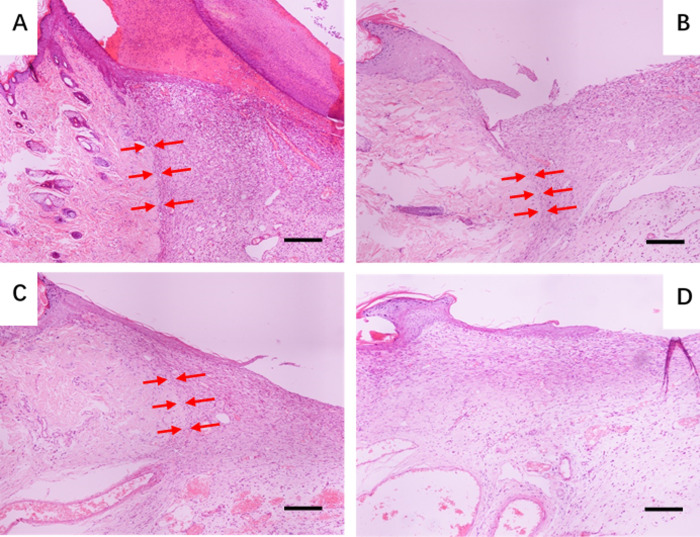
H&E staining of the tissue.Histological analysis of the tissue in the group of (A) PLGA, (B) PLGA/PDGF-BB, (C) p-DA/PLGA, and (D) pDA/PLGA/PDGF-BB with H&E staining. (The bars = 200 μm). The red arrows denote the border between regenerated tissues and normal tissues.